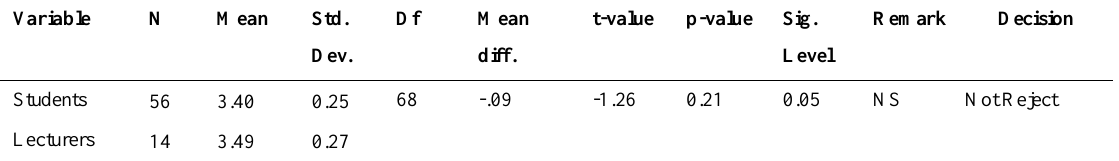
Table 6: t-test analysis of the grand mean responses of lecturers and students on the major factors responsible for insecurity in Nigeria